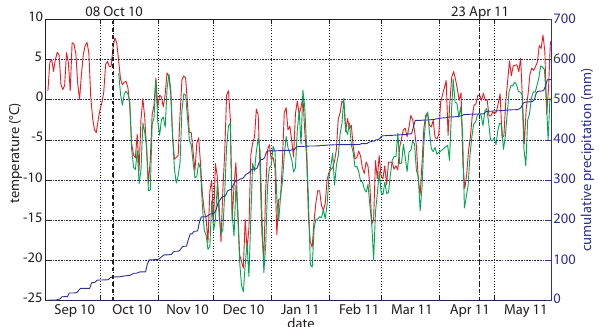
Fig. 3. Mean daily air temperature measured at the automatic weather station (AWS, Fig. 2) Hintereisferner (3027ma.s.l.; green curve) and the AWS Vernagtferner (2640ma.s.l.; red curve) for the accumulation season 2010/2011. Cumulative precipitation is shown for the AWS Vernagtferner (blue curve). Dates of ALS surveys are marked as dotted lines.